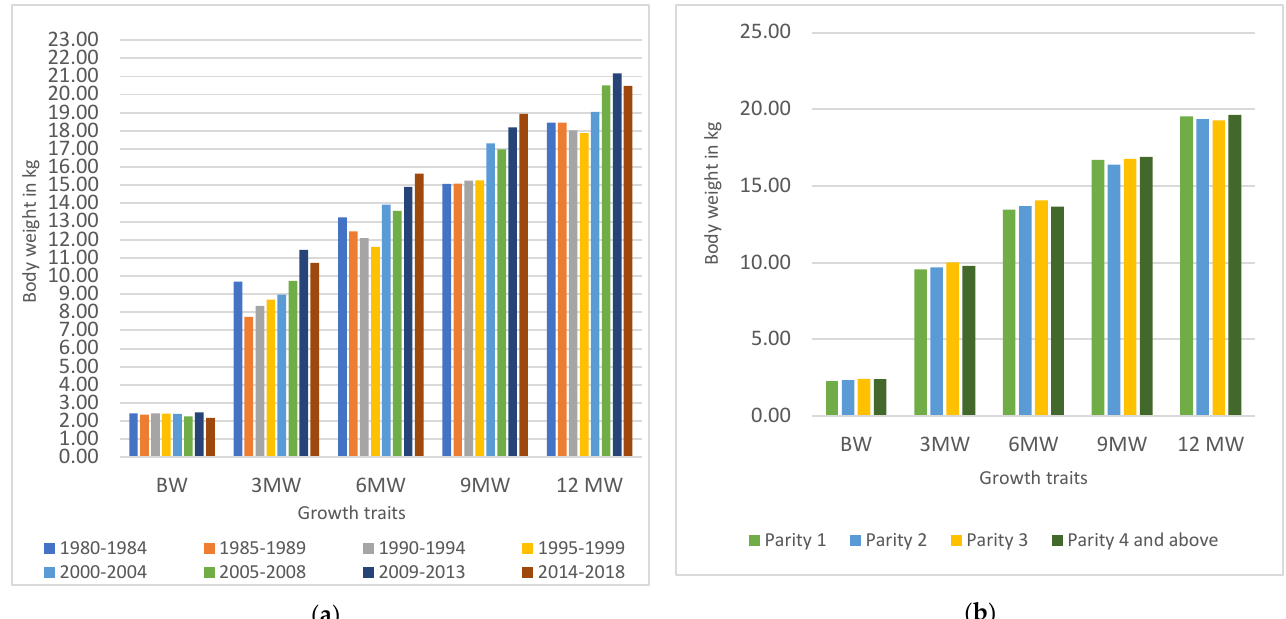
Figure 1. Influence of non-genetic factors on body-weight traits of Mecheri sheep: ( a ) effect of period of birth and ( b ) effect of parity.